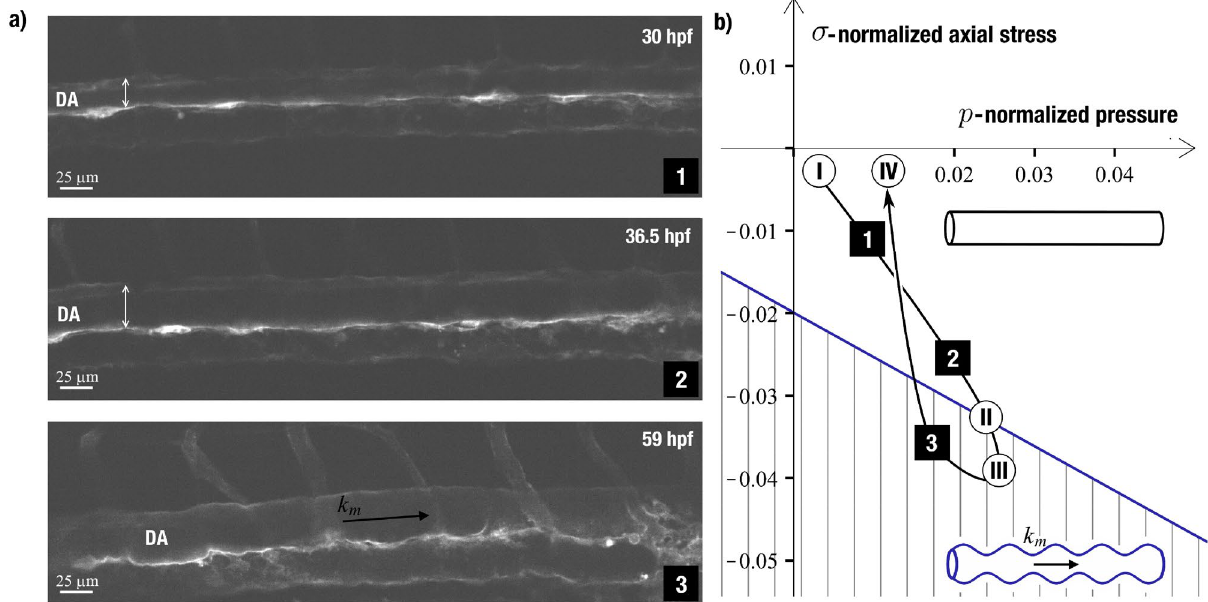
Figure 3. Live imaging of a zebrafish dorsal aorta morphogenesis from 30 to 60 hpf. ( a ) Pictures extracted from the live imaging of the Tg(kdrl:caax-mCherry) zebrafish embryo segments shows the DA morphological changes at 30 hpf, 36.5 hpf and 59 hpf. Arabic numerals conform to the b panel. ( b ) Trajectory describing ( i.e., normalized pressure difference and normalized p , σ the developmental process in the parameter space (cid:31) (cid:30) longitudinal stress). Arabic numerals correspond to the images in the a panel. Roman numerals correspond to the DA shape evolution stages: (I) initiation of the DA expansion; (II) emergence of the periodic pattern of thinner and thicker regions; (III) peaking of the DA radius; (IV) restoration of the initial shape of a straight 1 / 50 . Double-headed arrows show DA diameter variation. cylinder. Diagram corresponds to the tube with γ = Black arrow shows instability wave vector. Scale bar: 25 µm. See also Supplementary Videos S1 to